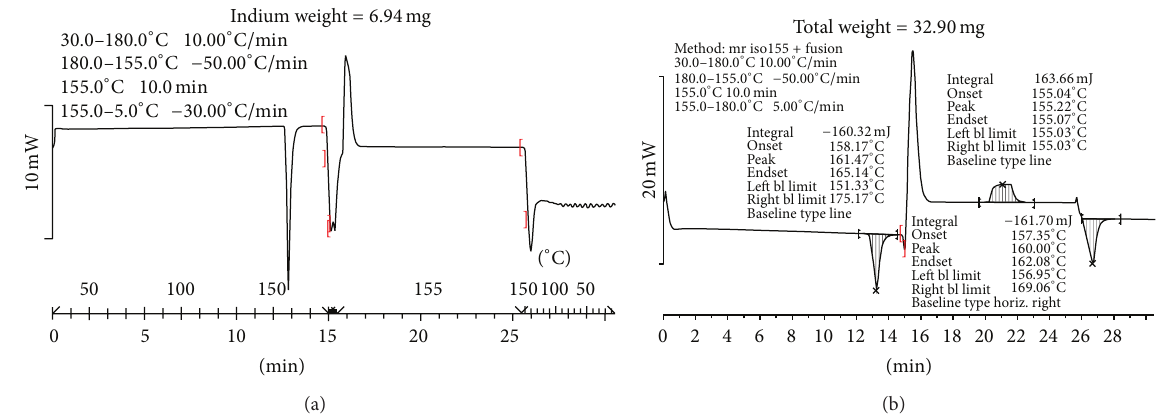
Figure 2: DSC curves of In, shown as an example. (a) In absence of PTFE; (b) in the presence of PTFE. An amount of c.a. 7 mg of In was first melted by heating up to 180 ∘ Cs −1 at a scan rate of 0.167 ∘ Cs −1 and then cooled up to 155 ∘ C at − 0.833 ∘ Cs −1 and left to this temperature for 600 s. The last heating run in procedure (b) only proves that the exothermal peak is due to In